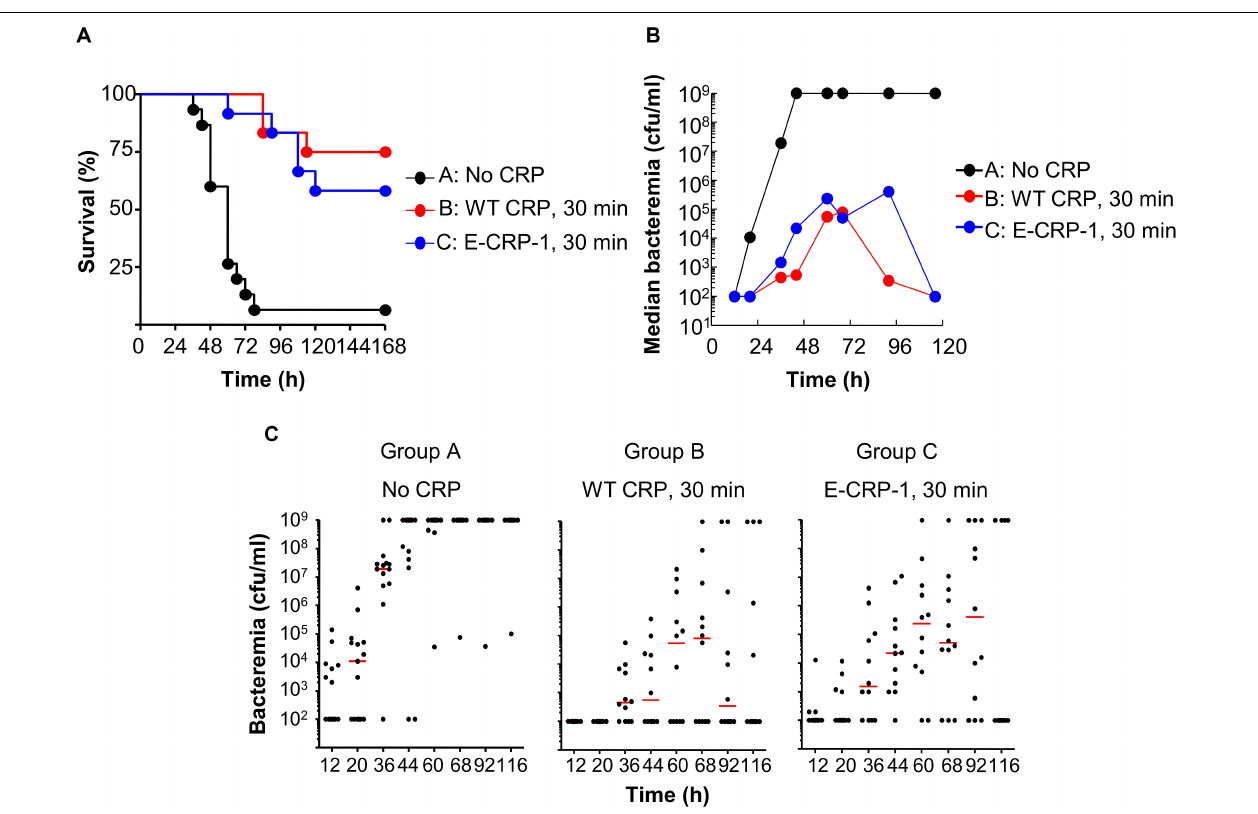
FIGURE 6 | Like WT CRP, E-CRP-1 is also protective against early-stage infection. The data are combined from two separate experiments with six to eight mice in each group in each experiment. (A) Survival curves. Pneumococci and CRP were injected 30 min apart. The p -values for the differences in the survival curves between groups A B, A C, and B C were < 0.001, < 0.001 and 0.43, respectively. (B) Bacteremia. Blood was collected from each surviving mouse shown in A . The median bacteremia values are plotted. For 36-116 h, the p -values for the differences between groups A B and A C were < 0.001. The p -value for the difference between groups B C was > 0.05 at all time points. (C) Scatter plots of the bacteremia data shown in B . The horizontal line in each group of mice represents median